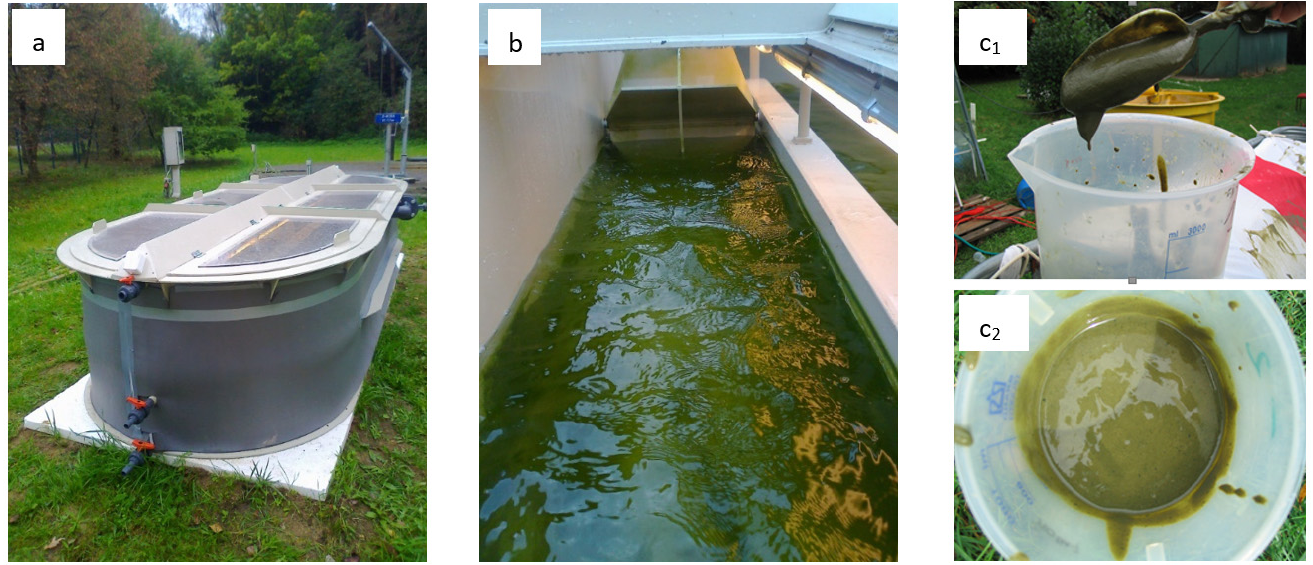
Figure 1. Pilot-scale photobioreactor (( a ) overview, ( b ) photobioreactor chamber, ( c 1 , c 2 ) concentrated microalgal biomass).